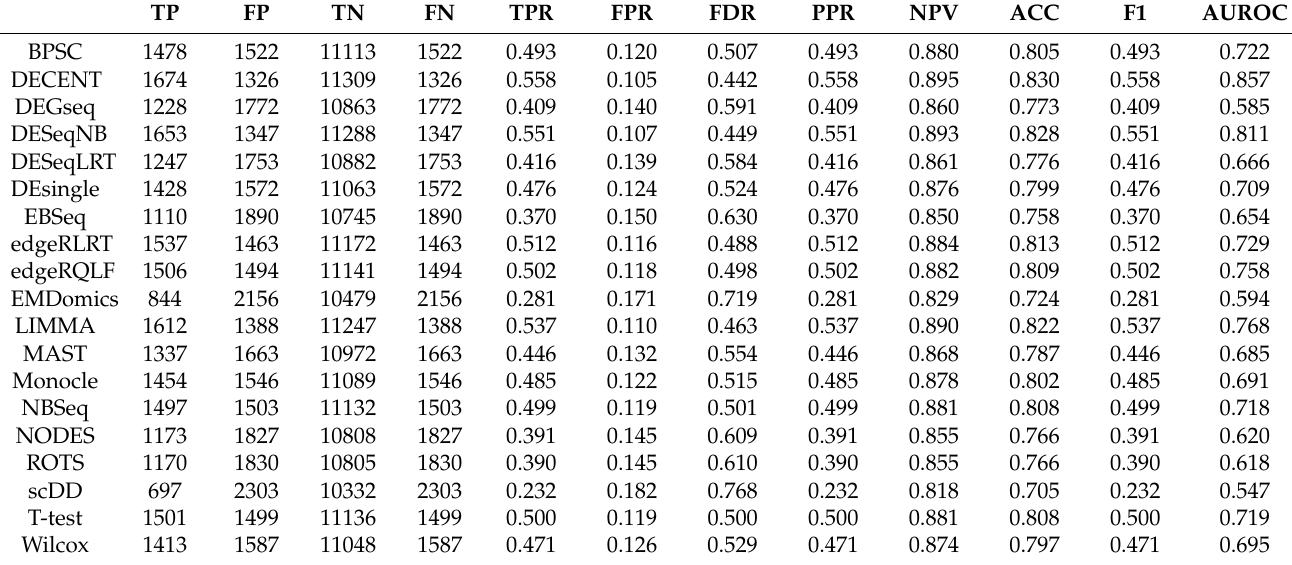
Table 4. Evaluation of DE methods based on performance evaluation metrics for Soumillon2 scRNA-seq